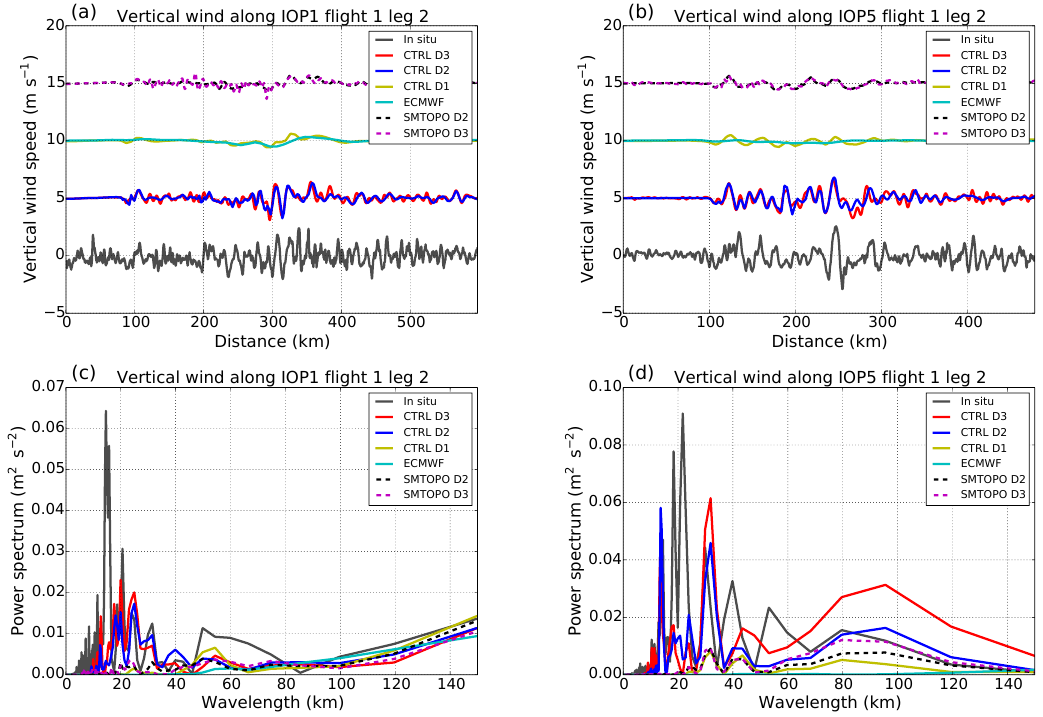
Figure 12. Comparison of vertical winds at flight level along leg 2 of flight 1 during (a, c) IOP1 and (b, d) IOP5. To improve readability, vertical wind speeds are shifted by 5ms − 1 in panels (a) and (b) . In panels (c) and (d) power spectra of vertical winds in panels (a) and (b) are shown. The corresponding spectra of the topography along the flight legs are plotted in Fig. 3.